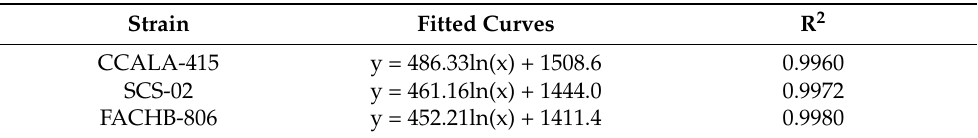
Table 2. The fitted curves of relative fluorescence intensity at the emission wavelength of 578 nm (the excitation wavelength at 545 nm) for Porphyridium cruentum CCALA-415, Porphyridium purpureum SCS-02 and Porphyridium purpureum